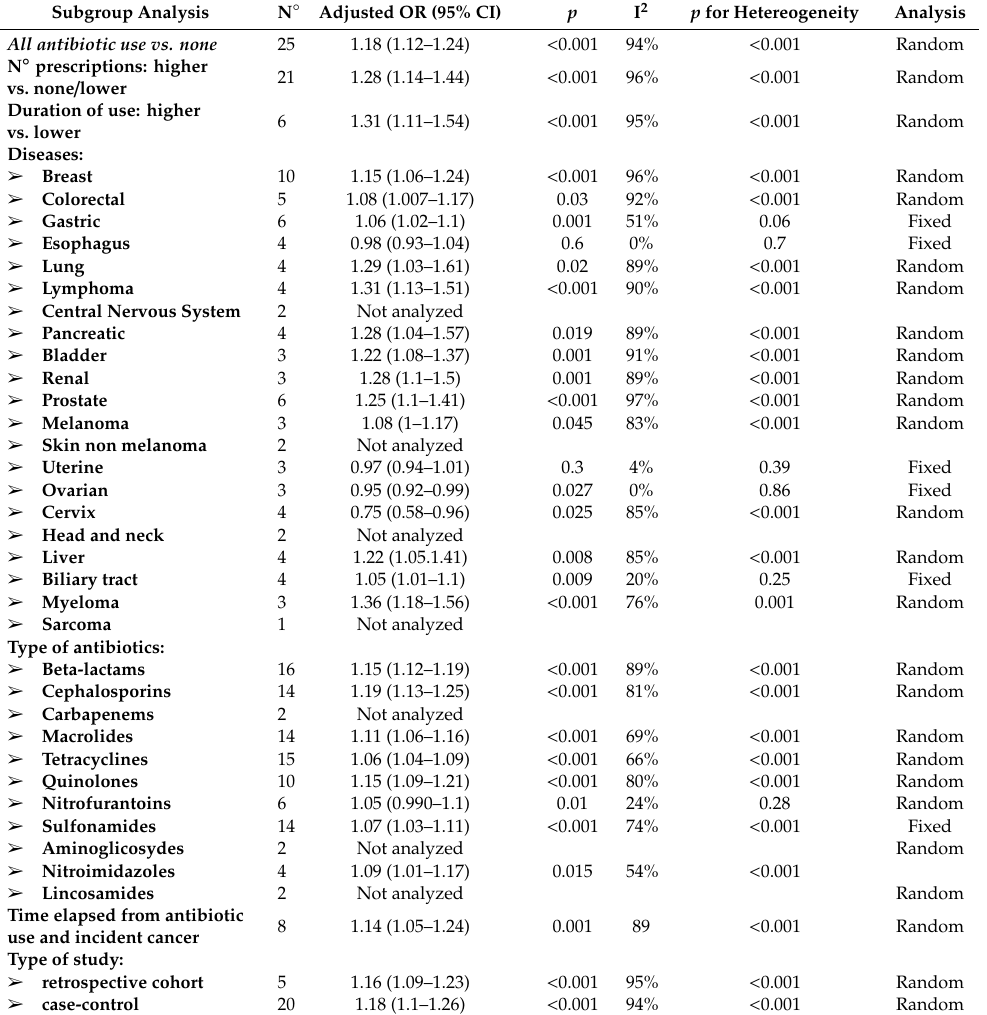
Table 3. Main results and subgroup